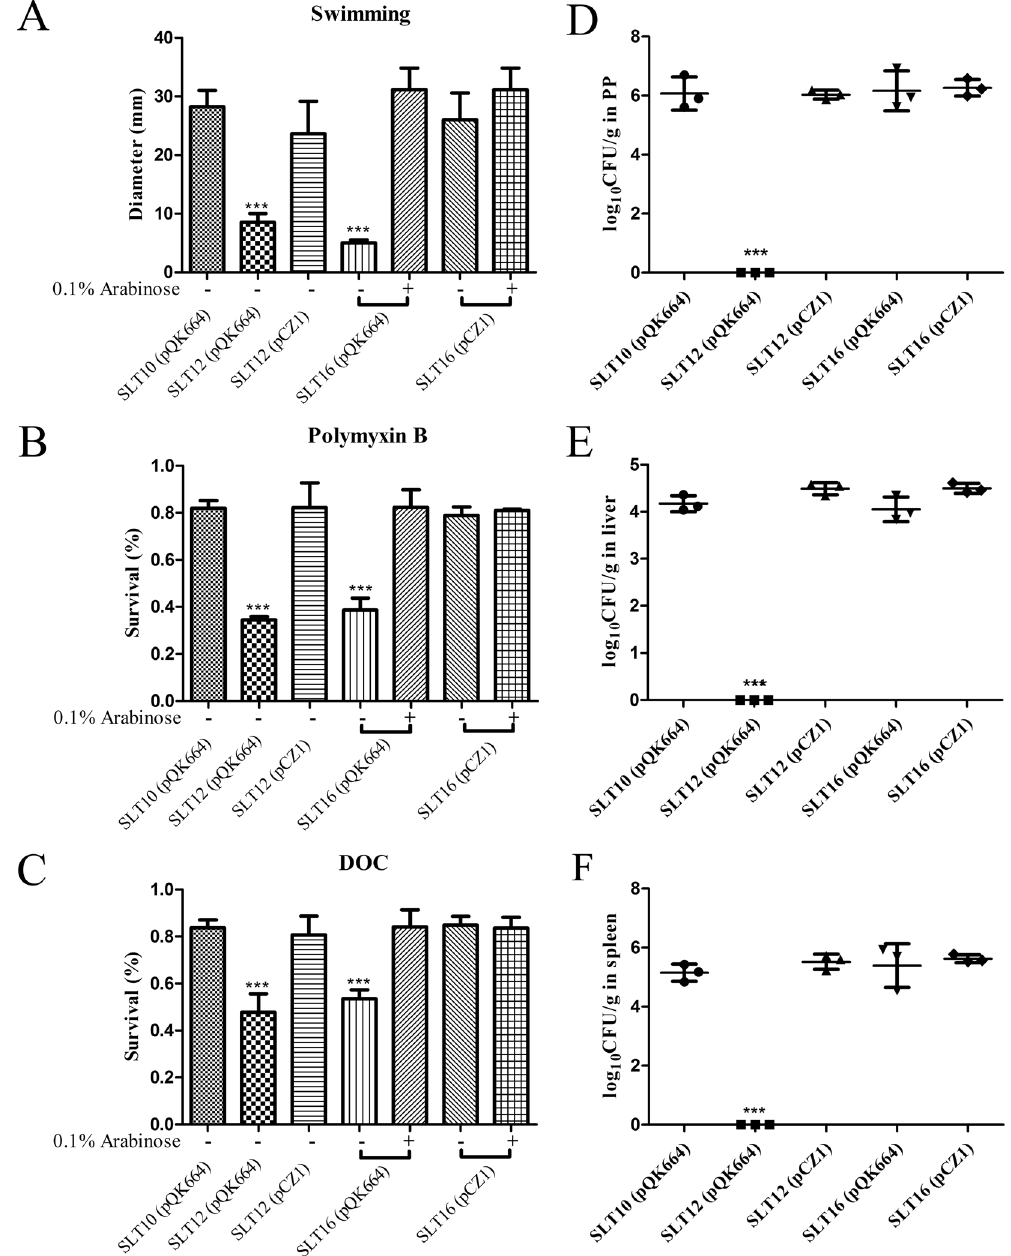
Figure 2. Effects of heterologous O-antigen expression on Salmonella Typhimurium biological activities. ( A ) Swimming assay. SLT10 (pQK664), SLT12 (pQK664), SLT12 (pCZ1) and the two arabinose-regulated strains SLT16 (pQK664) and SLT16 (pCZ1) were grown in LB broth with or without 0.1% arabinose. Then, 6 μ l of the bacterial suspension (approximately 1 × 10 6 CFU) was spotted onto the middle of LB plates containing 0.3% agar with or without arabinose, and the diameter of the colonies was measured 6 h after incubation. ( B and C ) Resistance to polymyxin and DOC. The same Salmonella Typhimurium strains described in A were cultured in LB broth with or without 0.1% arabinose. One-hundred microliters of the cell suspension (approximately 1 × 10 6 –5 × 10 6 CFU) was inoculated with or without 0.12 μ g/ml polymyxin B ( B ) or 4 mg/ml DOC ( C ) for 1 h at 37 °C. The bacteria were diluted and plated onto LB plates, and the survival rate was calculated the following day. ( D , E and F ) Colonization. Groups of BALB/c mice (n = 4/group) were orally inoculated with 1 × 10 9 CFU of each indicated strain. Viable bacteria were recovered from PP ( D ), liver ( E ) and spleen ( F ) 6 days after infection. The bacterial number in each tissue was calculated as log 10 CFU/g. The asterisk above the error bar indicates significance compared to the SLT10 (pQK664) group. *** p <